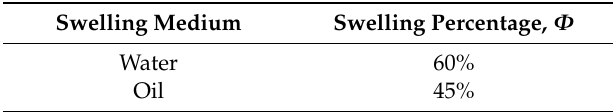
Table 1. Percentage mass swelling of paper in di ff erent